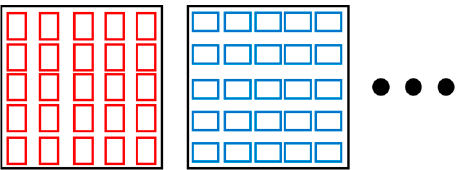
Figure 4. Anchor boxes for object detection. The number of anchor boxes corresponds to the number of grids in Figure 1a. The number and size of the anchor boxes was pre-determined. In interference, the location and size of the detected objects were denoted using the di ff erence from the location and the size of the anchor